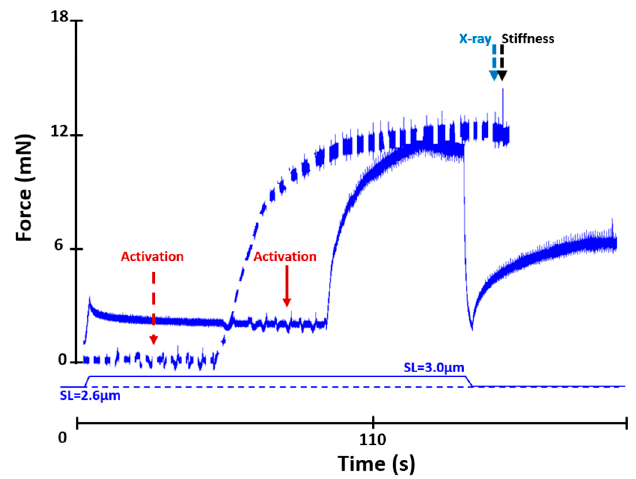
Figure 6. Force–time history of a reference (dashed line) and an active shortening contraction (solid line). In the reference contraction, the fibre was activated at an average SL of 2.6 µ m. In the active shortening contraction, the fibre was passively stretched from an average SL of 2.6 µ m to an average SL of 3.0 µ m, activated, and then actively shortened to an average SL of 2.6 µ m. Activation occurred when the relaxing solution in the testing chamber was replaced by a washing solution (free of EGTA and calcium) and then an activating solution (pCa 4.2). The noise in the graphs indicates the time when the solutions were changed. The dashed line arrows indicate events in the reference contraction, while the solid line arrows indicate events in the active shortening contraction. The fibre was exposed to X-rays at steady-state isometric contraction following activation at an average SL of 2.6 µ m in the reference condition, and following active shortening from an average SL of 3.0 to 2.6 µ m in the active shortening condition. Stiffness was measured after exposure to X-rays.